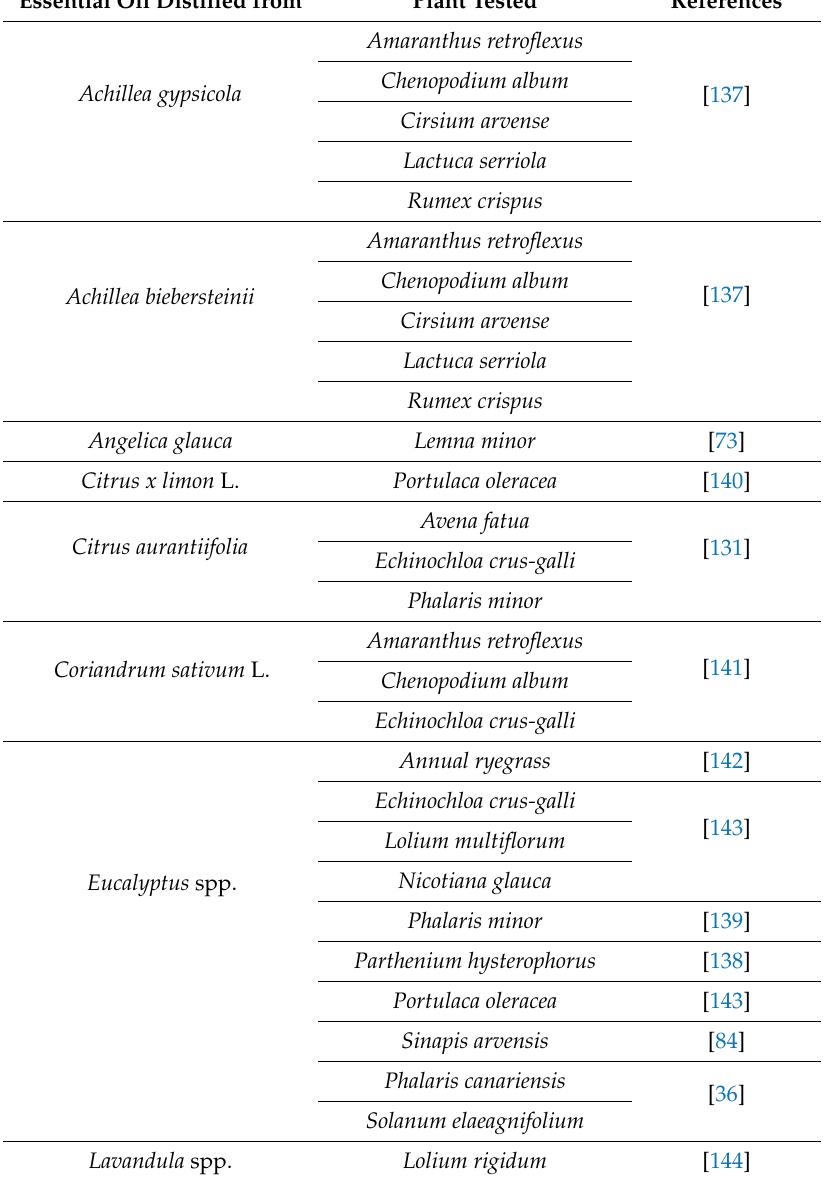
Table 3. Examples of EO presenting herbicidal